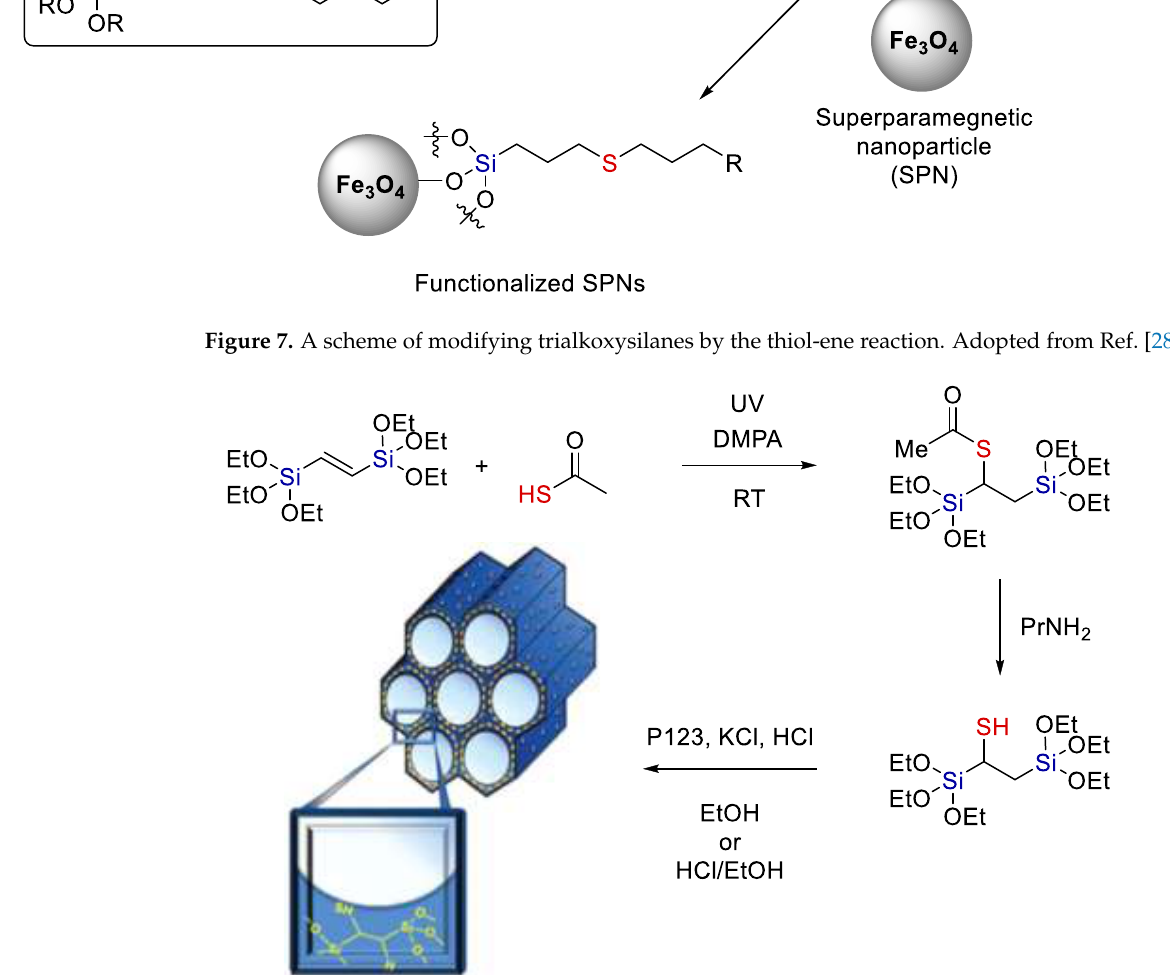
Figure 7. A scheme of modifying trialkoxysilanes by the thiol-ene reaction [28].